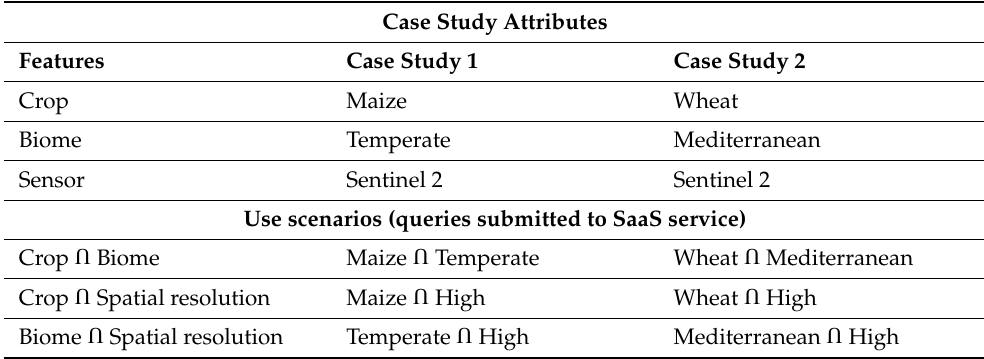
Table 1. List of the attributes of the two case studies and corresponding use scenarios. Ո indicates the intersection between two specific attributes of the case studies.